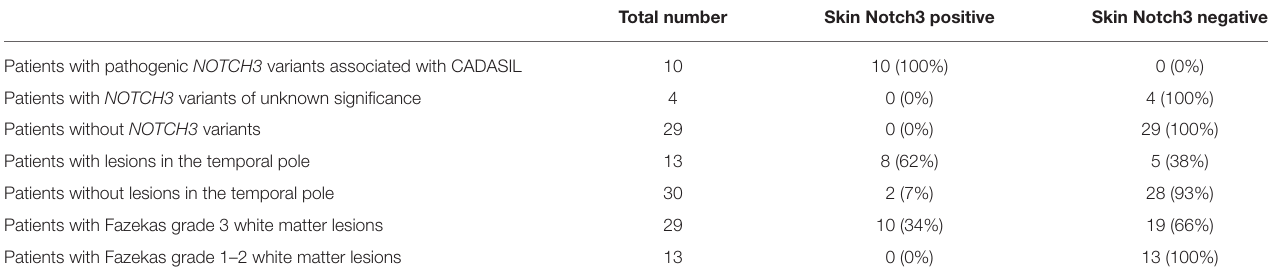
TABLE 2 | Number of patients with and without skin Notch3 deposits among patients with suspected CADASIL. Total number Skin Notch3 positive Skin Notch3 negative